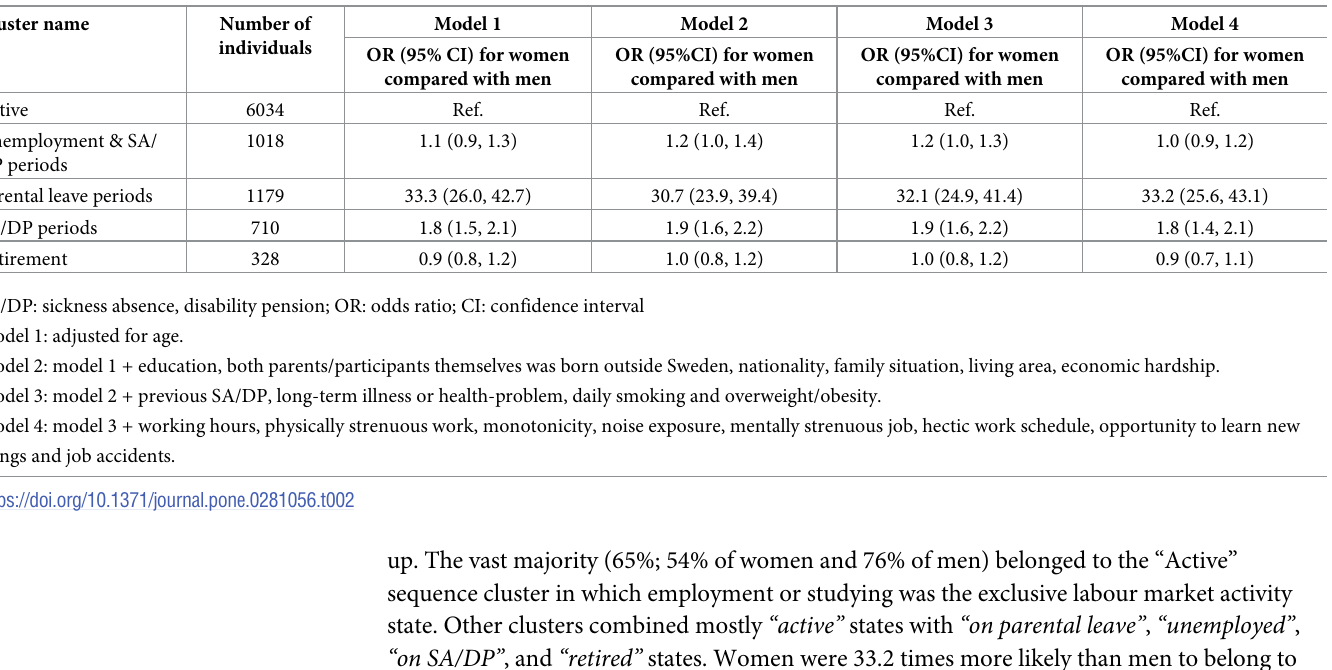
Table 2. Multinomial regression analysis for the associations between sex and different working life sequence